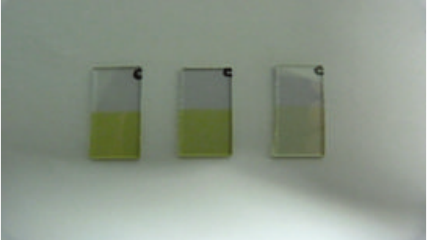
Figure 1: V 2 O 5 thin films were used in the calibration techniques with 160, 110, and 48 nm of thickness, respectively, from left to right, measured by